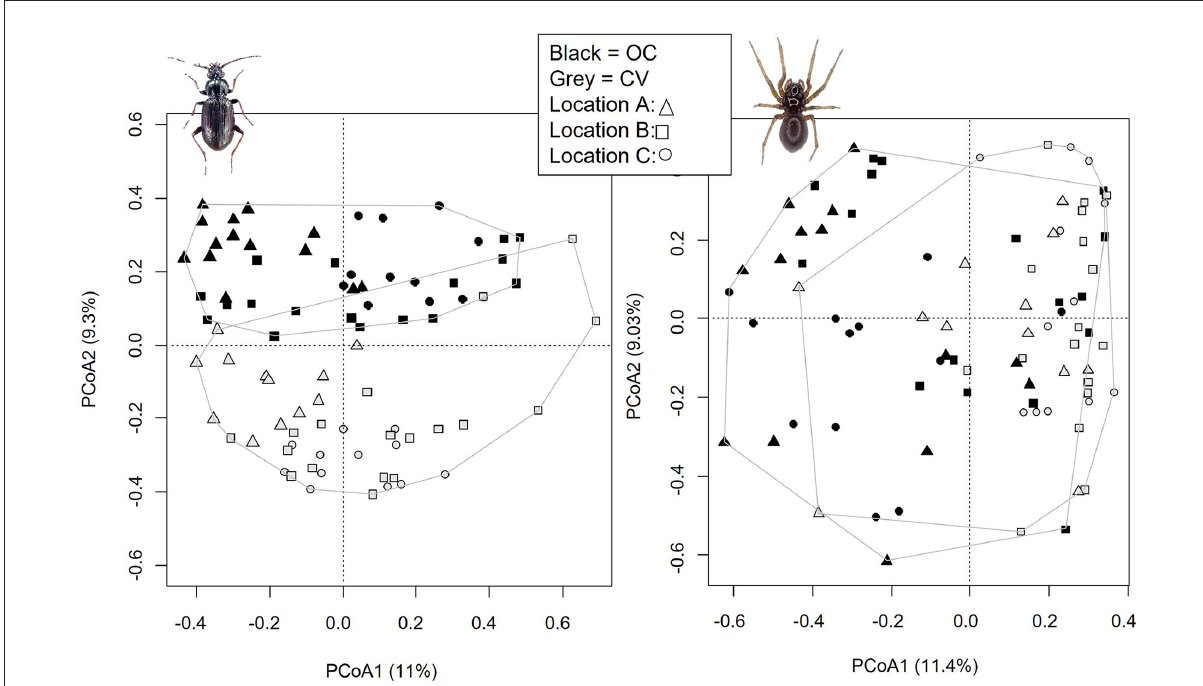
FIGURE3 Principal Coordinates Analyses (PCOA) represented under their two principal components for carabids (left) and spiders (right) . System types are represented in colors with black for organic-conservation (OC) parcels and gray for conventional (CV) ones. Shapes represent locations. Each system type is surrounded to help visualization.